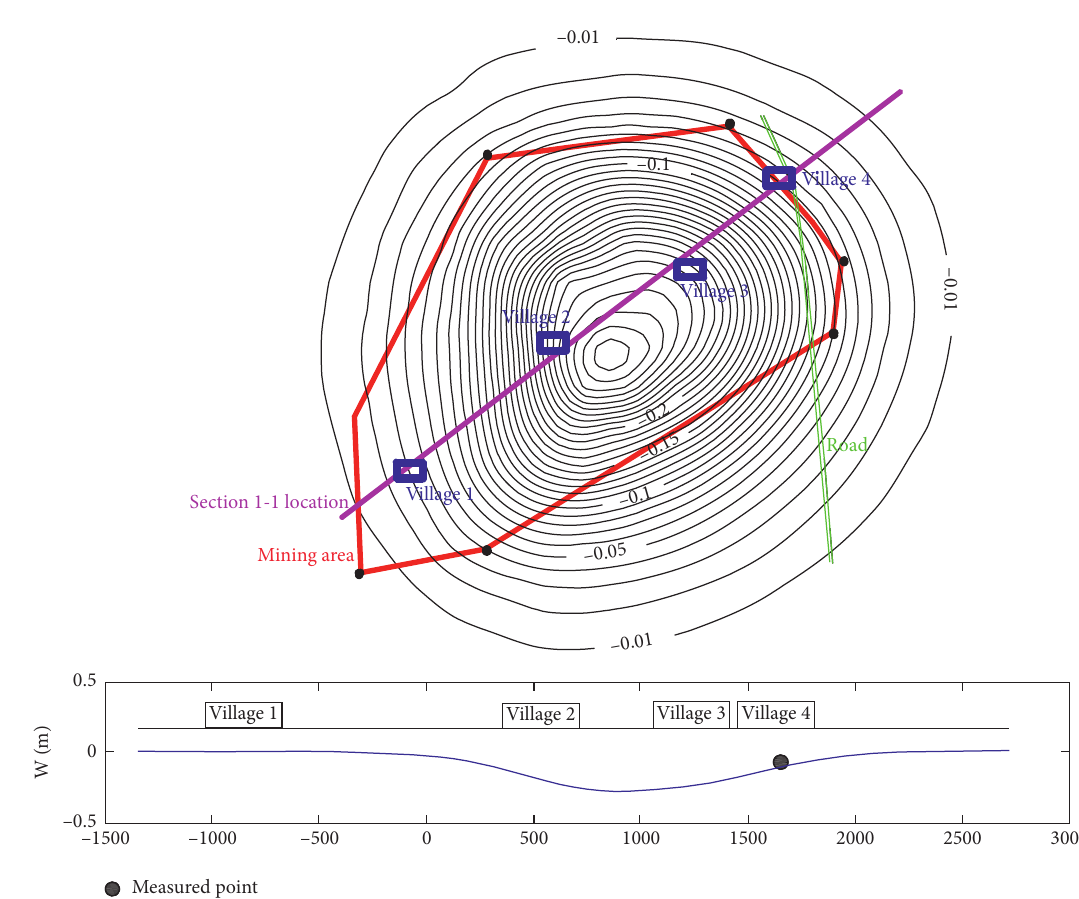
Figure 13: Surface subsidence contour map.